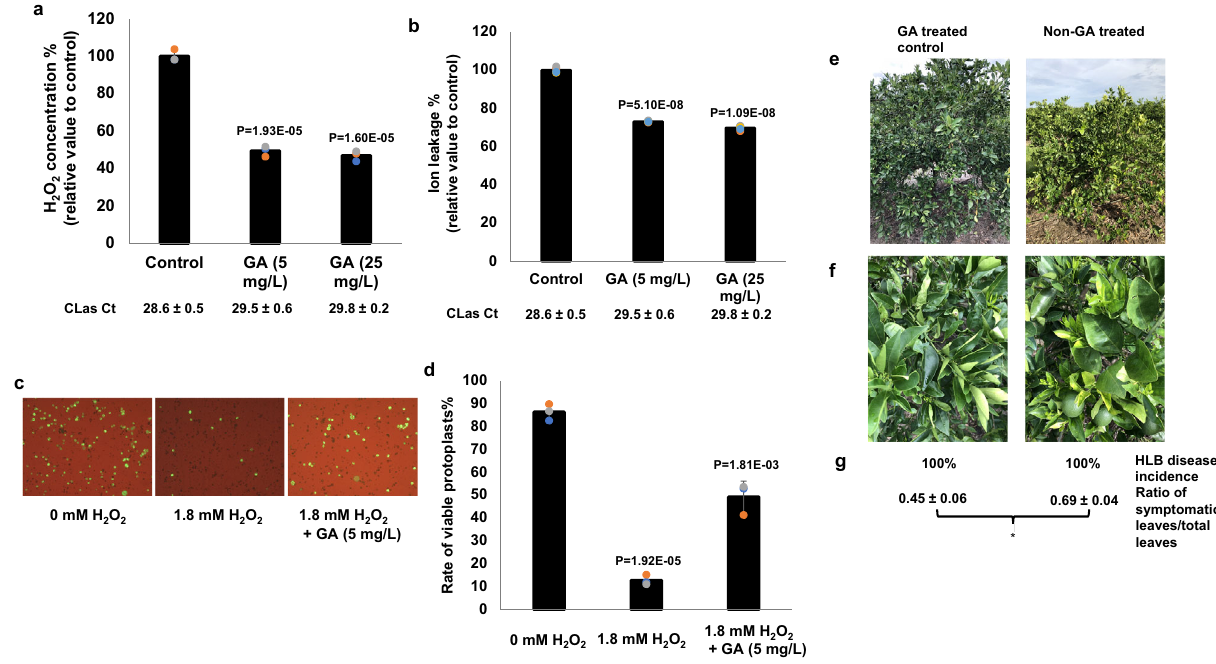
Fig. 6 The immunoregulator gibberellin (GA) suppresses HLB development. a , b GA suppresses ROS-mediated cell death. HLB-positive C. sinensis trees were treated with GA via foliar spray weekly for 6 weeks. The exudates extracted from phloem-enriched bark tissues were used for detection of H 2 O 2 ( a ) and ion leakage ( b ). Ct values of CLas of the tested samples were indicated. c , d GA suppresses cell death of C. sinensis protoplast cells. Freshly prepared protoplast cells of C. sinensis were treated with H 2 O 2 with or without GA (5 mg/L) for 24 h and tested for viability via fl uorescein diacetate (FDA) staining. Statistical differences ( a , b , d ) were analyzed using two-tailed Student ’ s t test. Mean ± SD ( a , n = 3; b , n = 4; d , n = 3) are shown. P valued are shown above each columb. e – g Foliar spray of GA suppresses HLB symptoms. C. sinensis “ Valencia ” blocks were treated with GA (1247 ppm) in November 2020. Nearby blocks of C. sinensis “ Valencia ” that were not treated with GA were used as negative controls. Symptoms, HLB disease incidence and ratio of symptomatic leaves/total leaves were investigated in June 2021. e Representative whole trees. f Representative sections. g HLB disease incidence and ratio of symptomatic leaves vs. total leaves in different treatments. * indicates P value <0.05 based on Student ’ s t test. Pictures were taken at the same day in June 2021. Source data are provided as a Source Data